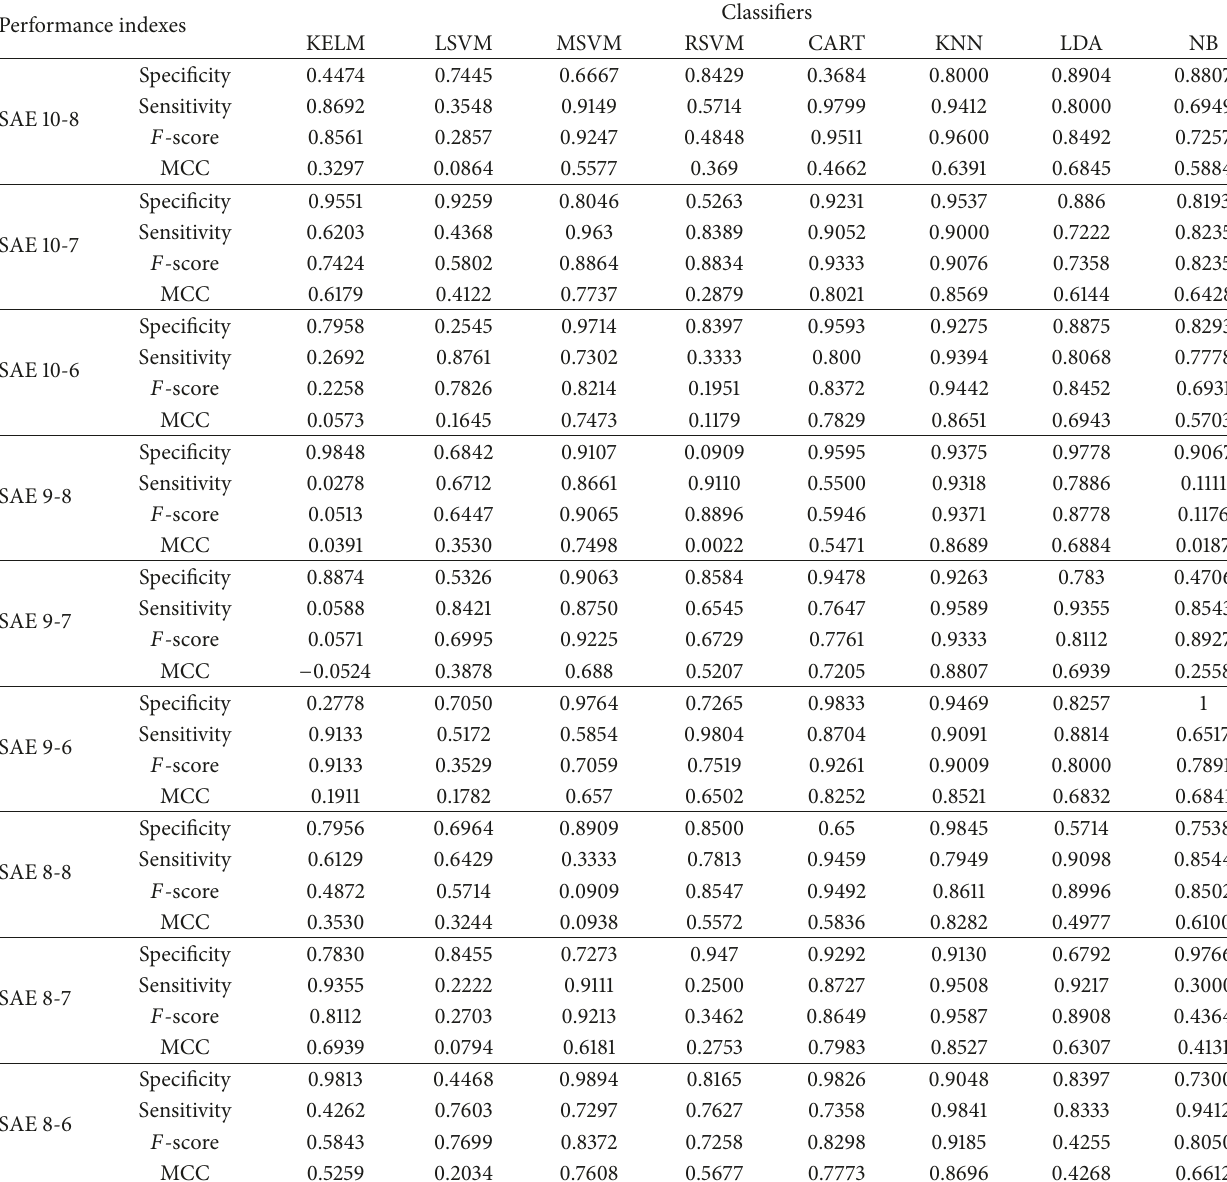
Table 8: Performance indexes of comparative classifiers without SAE on Istanbul Dataset (average values of 10 runs). Performance